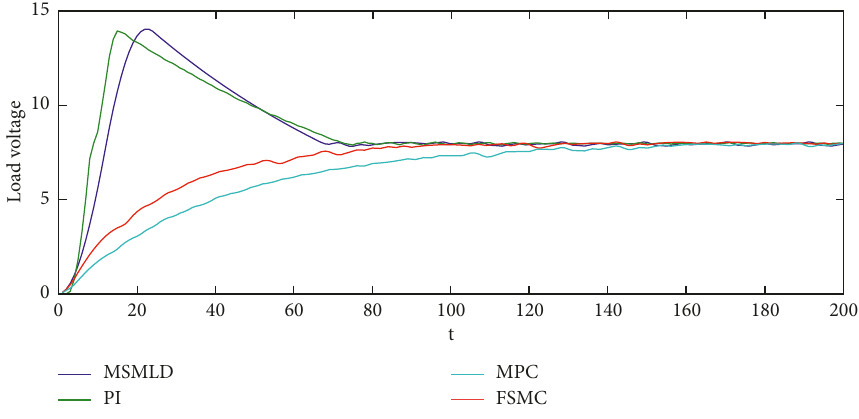
Figure 9: Comparison of different control